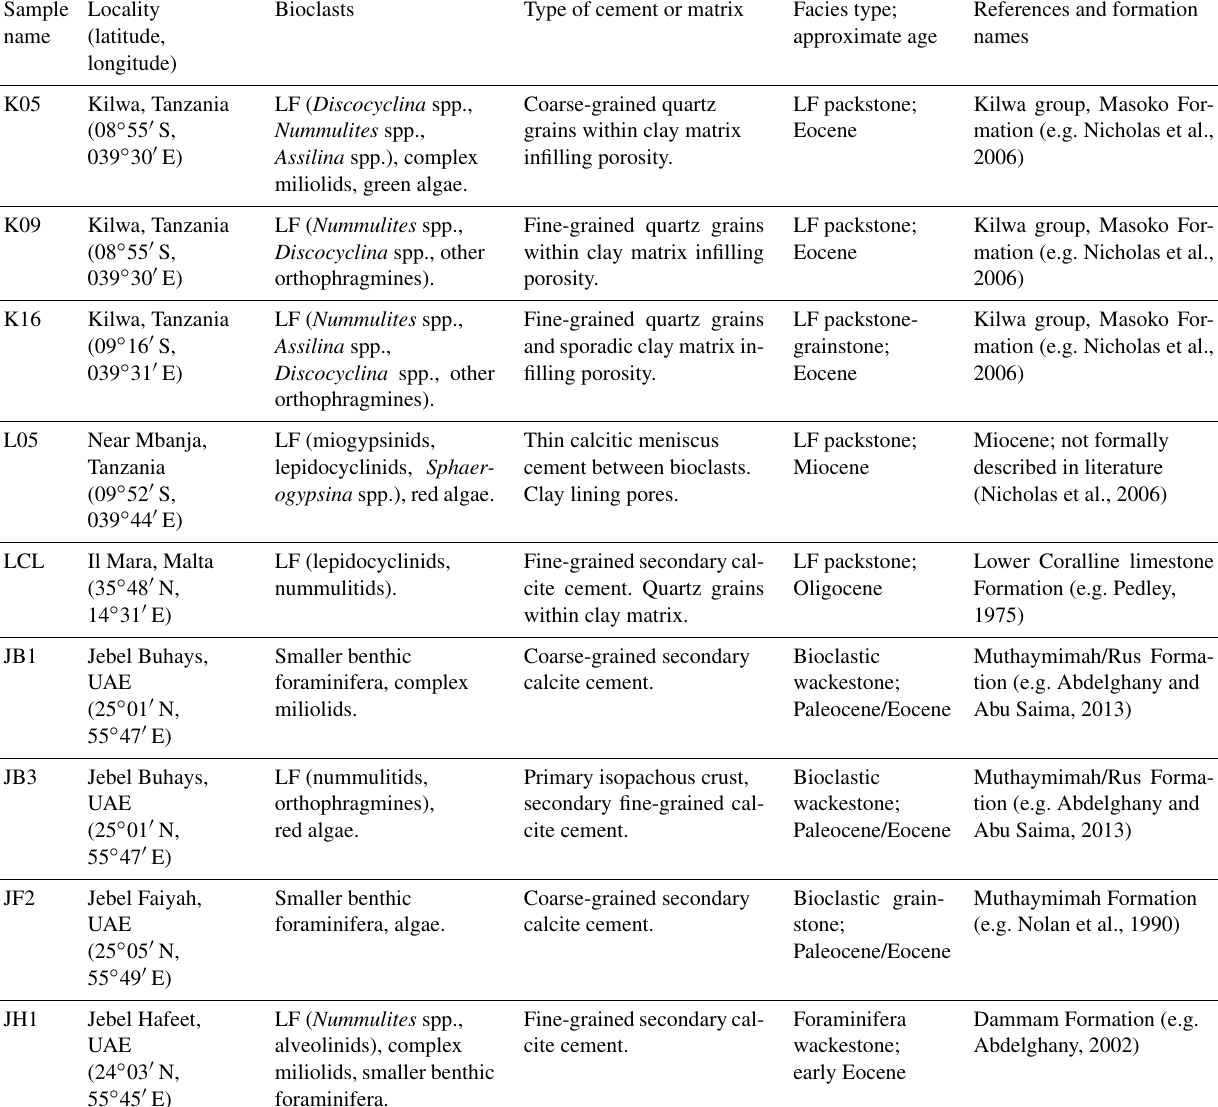
Table 1. Details of the different samples used in this study. The details of the biota were identified in thin sections and are shown in Fig. 2.